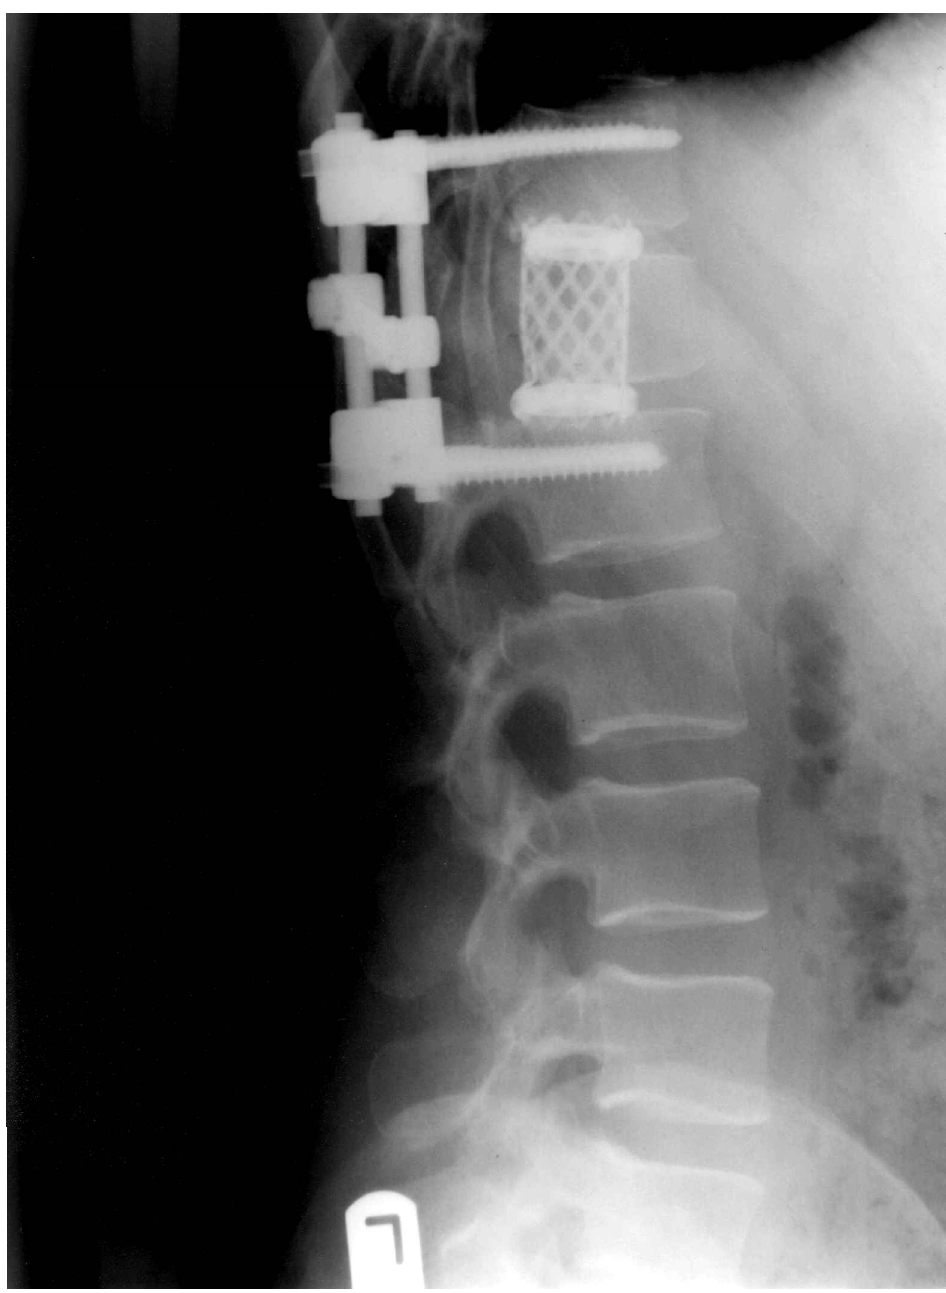
Fig. 5. Post-operative X-ray showing the position of the